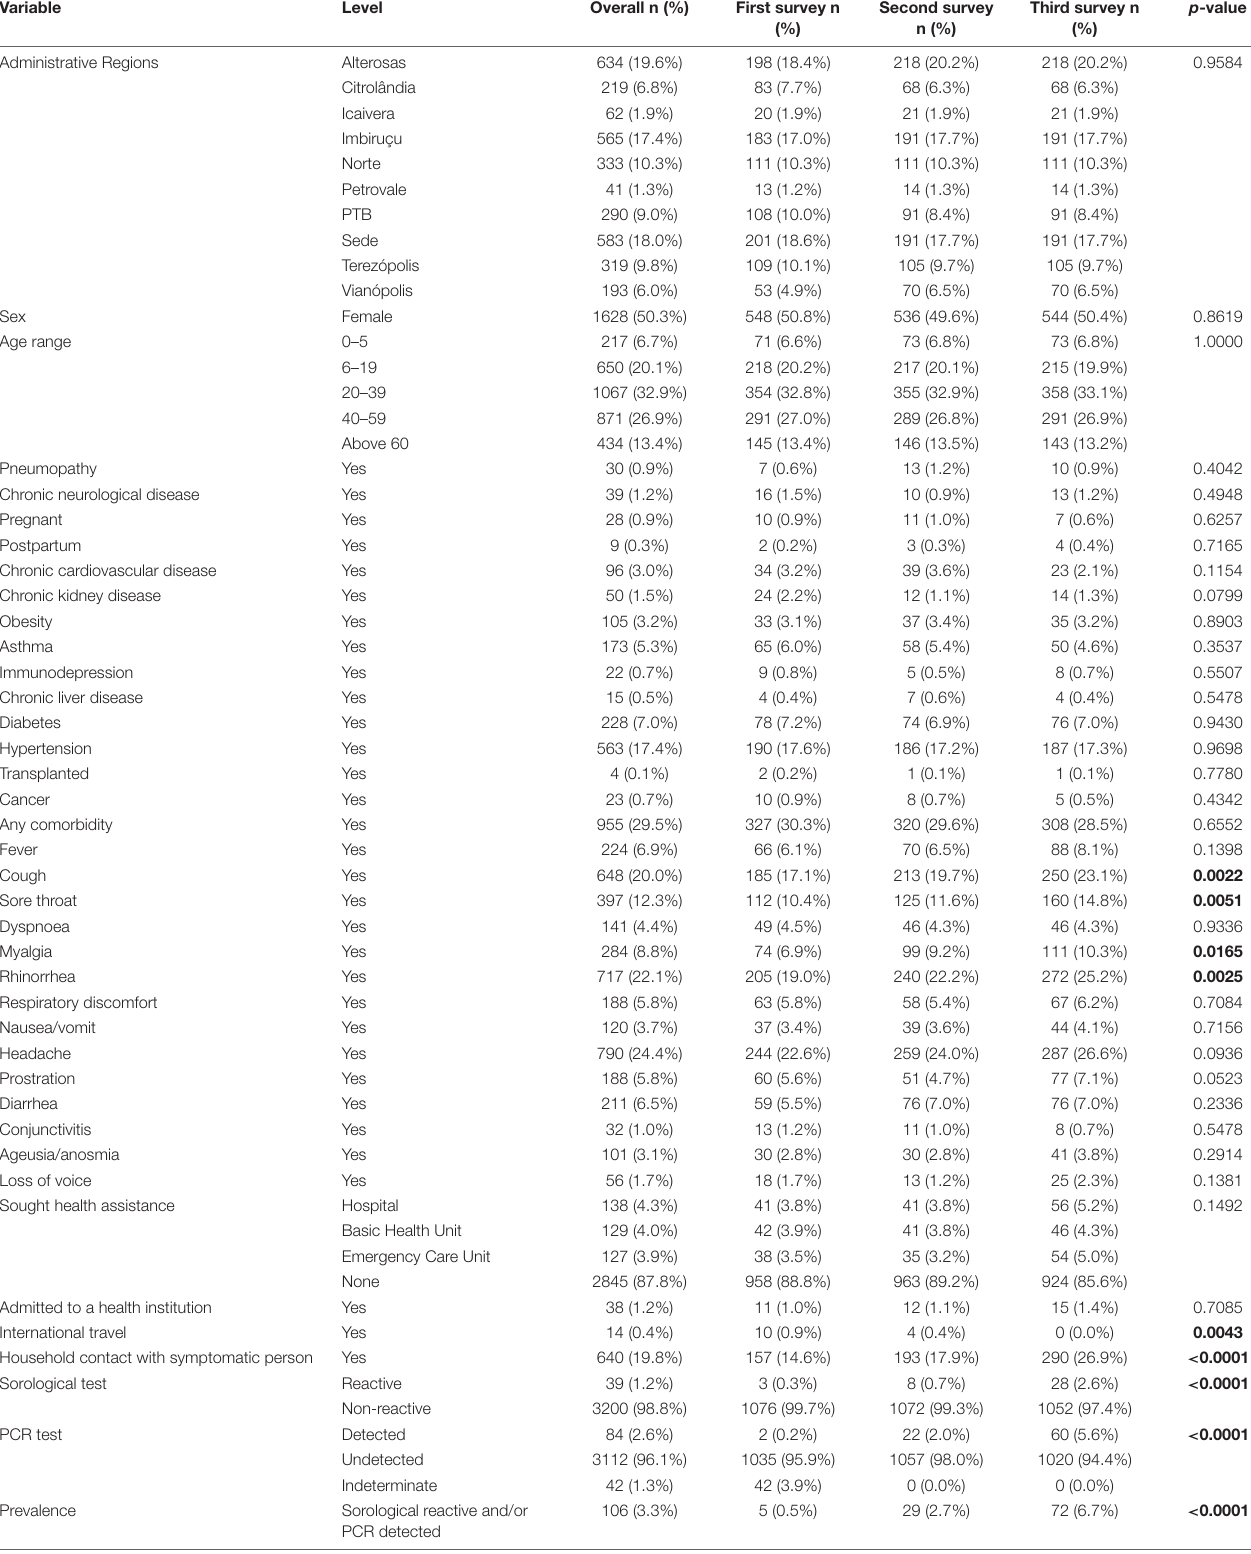
TABLE 1 | Clinical and epidemiological data obtained from